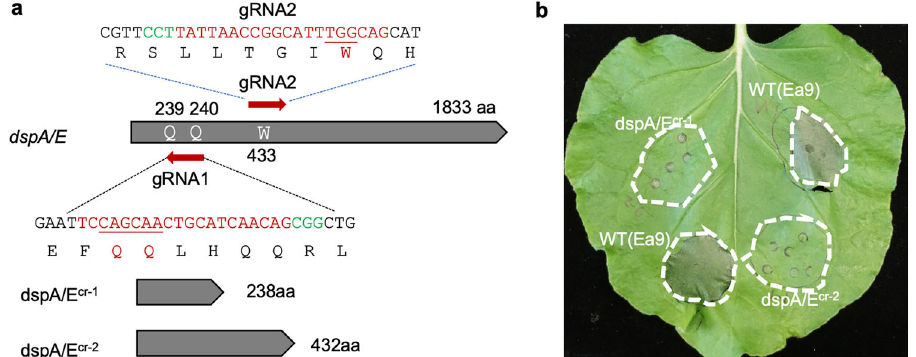
Fig. 4 Erwinia dspE/A mutants lost the ability to induce HR in N. benthamiana . a Schematic of dspA/E and the CBE-induced deletions resulting in dspA/ E cr-1 and dspA/E cr-2 . Q, glutamine; W, tryptophan. The numbers indicate the positions of triplets in the dspA/E coding sequences (in red). Two types of truncated mutants are shown. b N. benthamiana leaf 48 h after in fi ltration with parallel dilution series of suspensions of strains Ea9 (WT) and Ea9 dspE/A mutant 1 (239 aa) and mutant 2 (432 aa). The concentrations in fi ltrated are 5 × 10 7